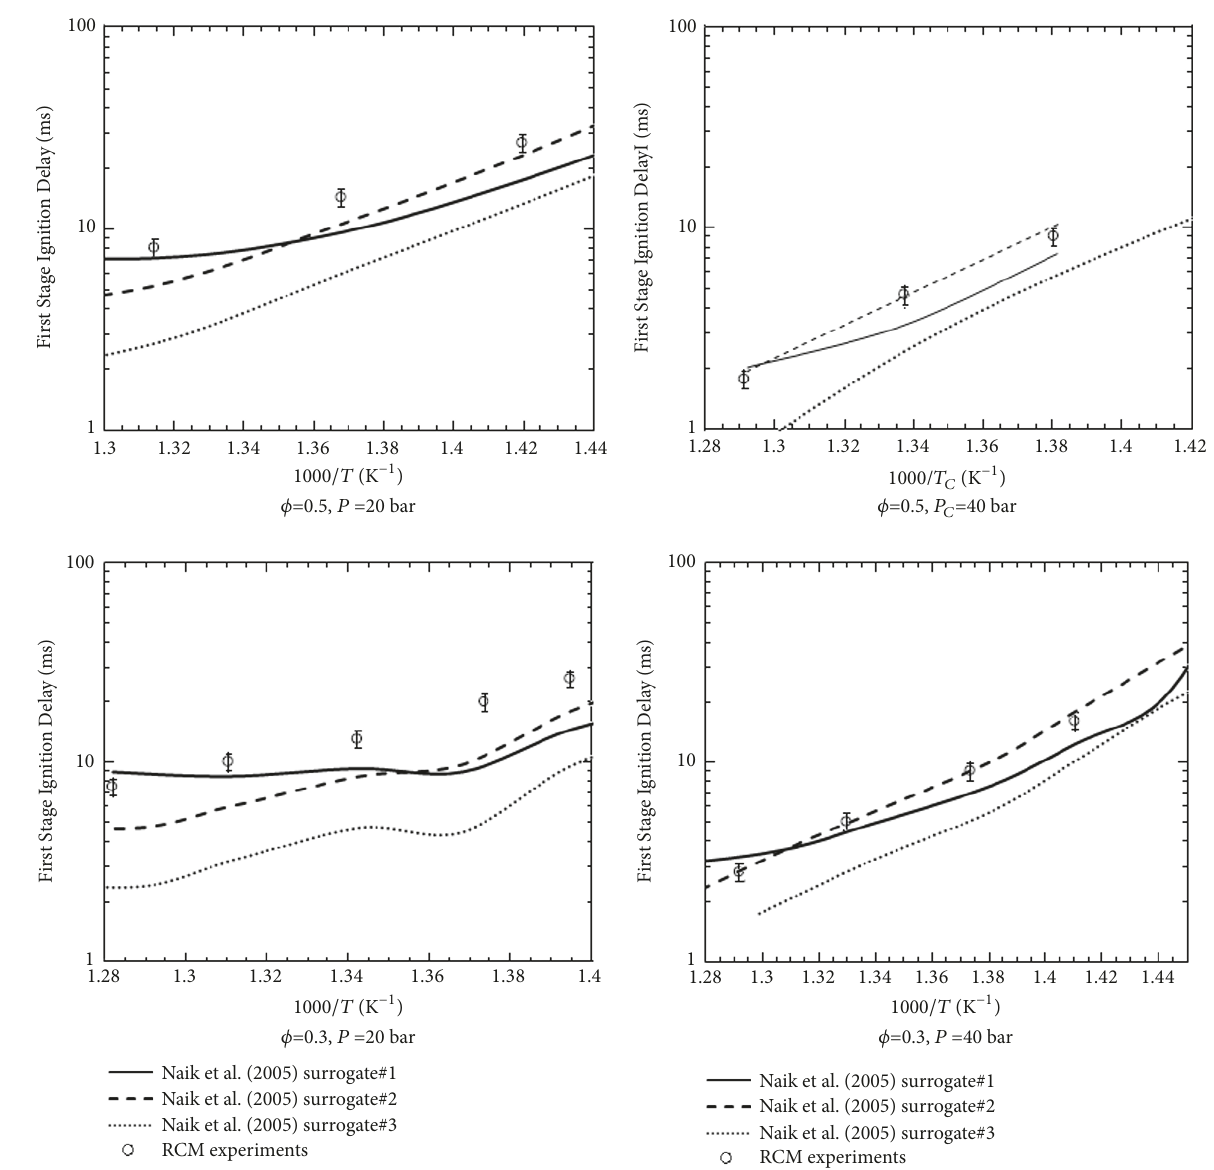
Figure 16: Comparison of experimental and simulated first-stage ignition delay times. Experimental data is from Kukkadapu et al. [23]. Surrogate simulations were carried out using Naik et al. [33] surrogates using the mechanism of Samimi Abianeh et al.